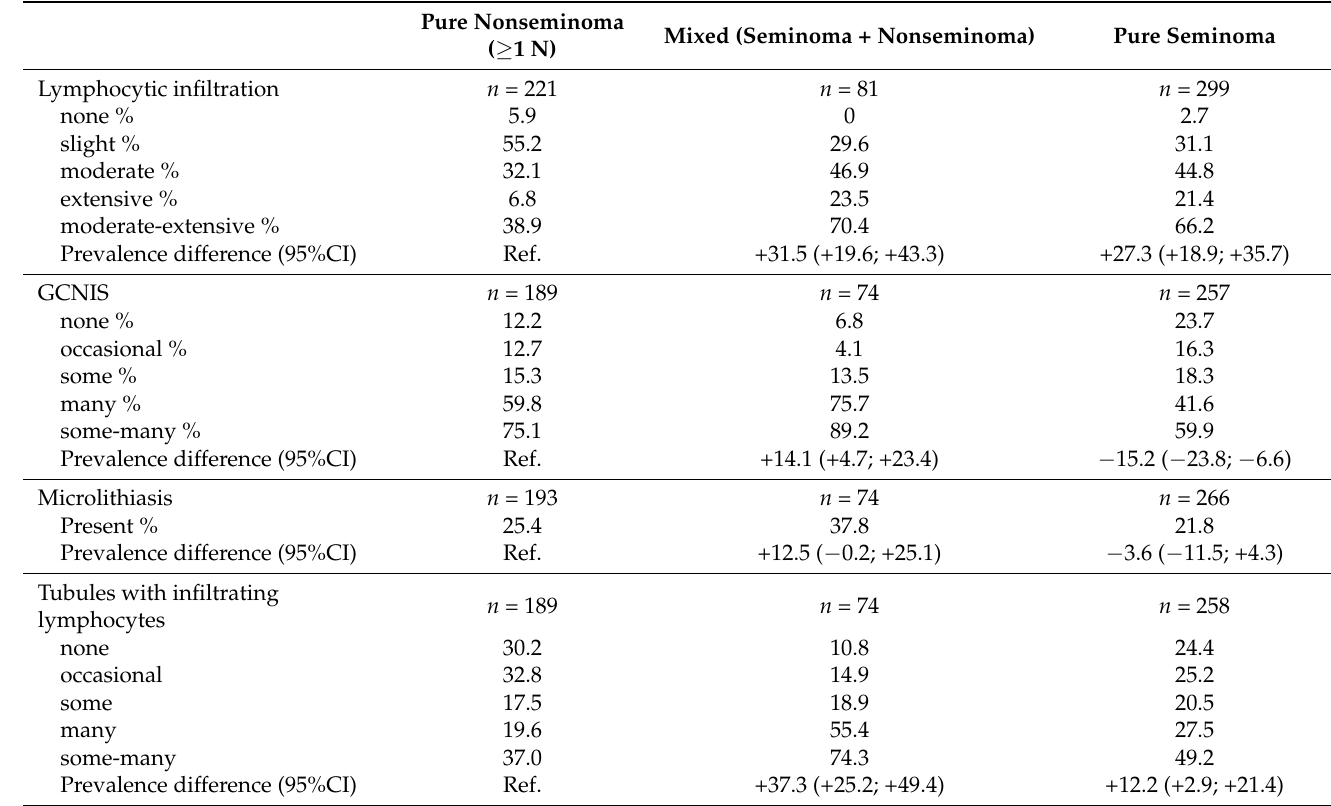
Table 3. Lymphocytic infiltration, germ cell neoplasia in situ (GCNIS), testicular microlithiasis (TM), and tubules with infiltrating lymphocytes in relation to histological